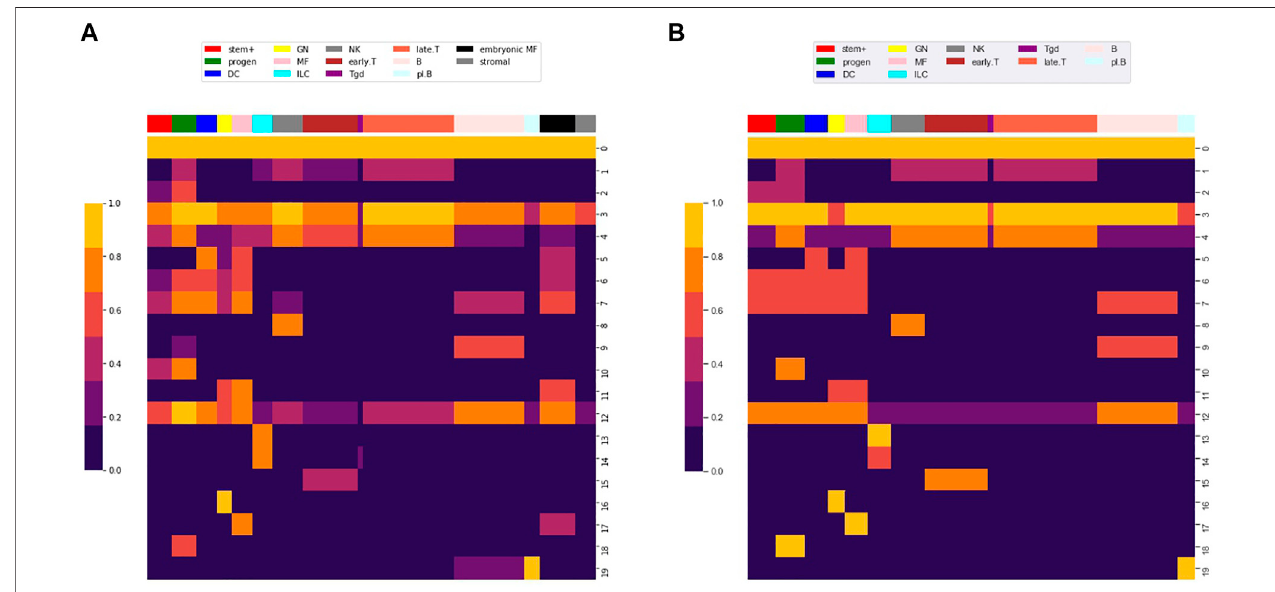
FIGURE 5 | Co-clustered approximation of the accessibility matrix M . Heatmaps of (A) ~ M ( 12 ) and (B) ~ M ( 12 ) i / a . Panel A also includes cluster means for embryonic macrophages (MF) and stromal cells, which are not part of ~ M